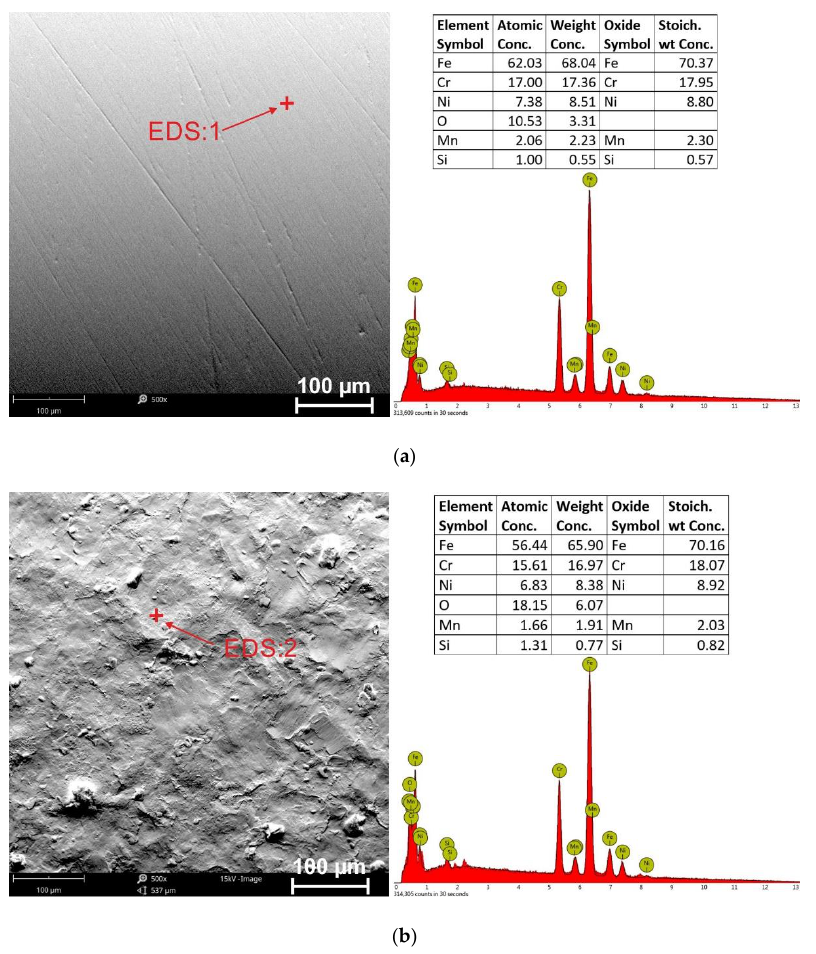
Figure 4. Stainless steel surfaces: ( a ) unpeened (304) and ( b ) shot-peened (sample 304/0.4/60), SEM-EDS.